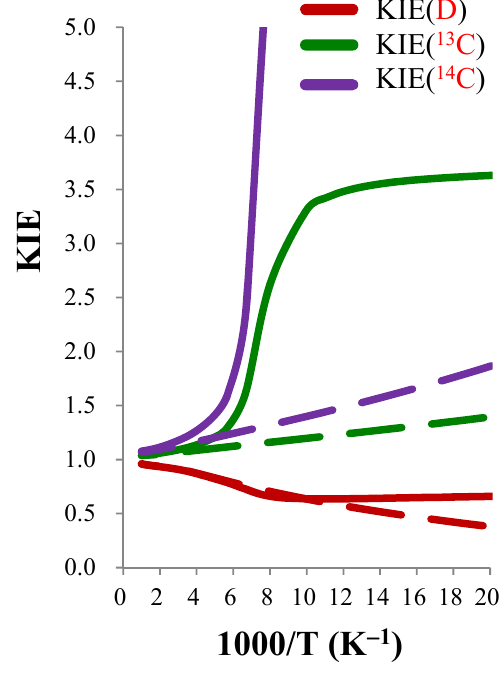
Figure 4. Calculated temperature dependence of the deuterium, 13 C, and 14 C KIEs of the gas phase CN − + CH OCl reactions. The broken and solid lines indicated results obtained 3 at the TST and CVT/SCT levels,